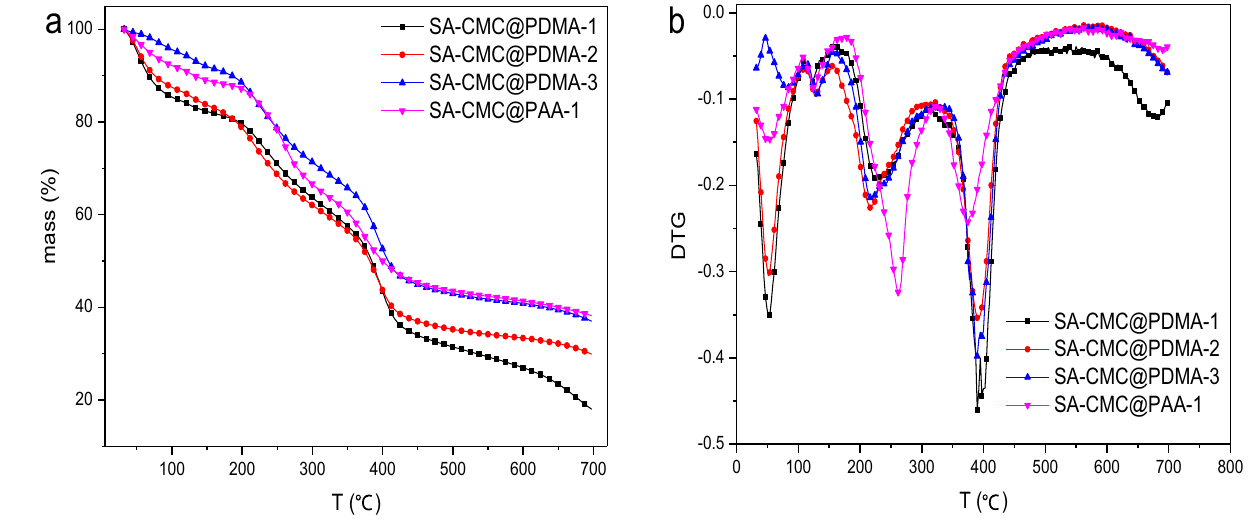
Figure 7. ( a ) The TG curves of SA-CMC@PDMA-1, 2,3 and SA-CMC@PAA-1; ( b ) The DTG curves of SA-CMC@PDMA-1, 2,3 and